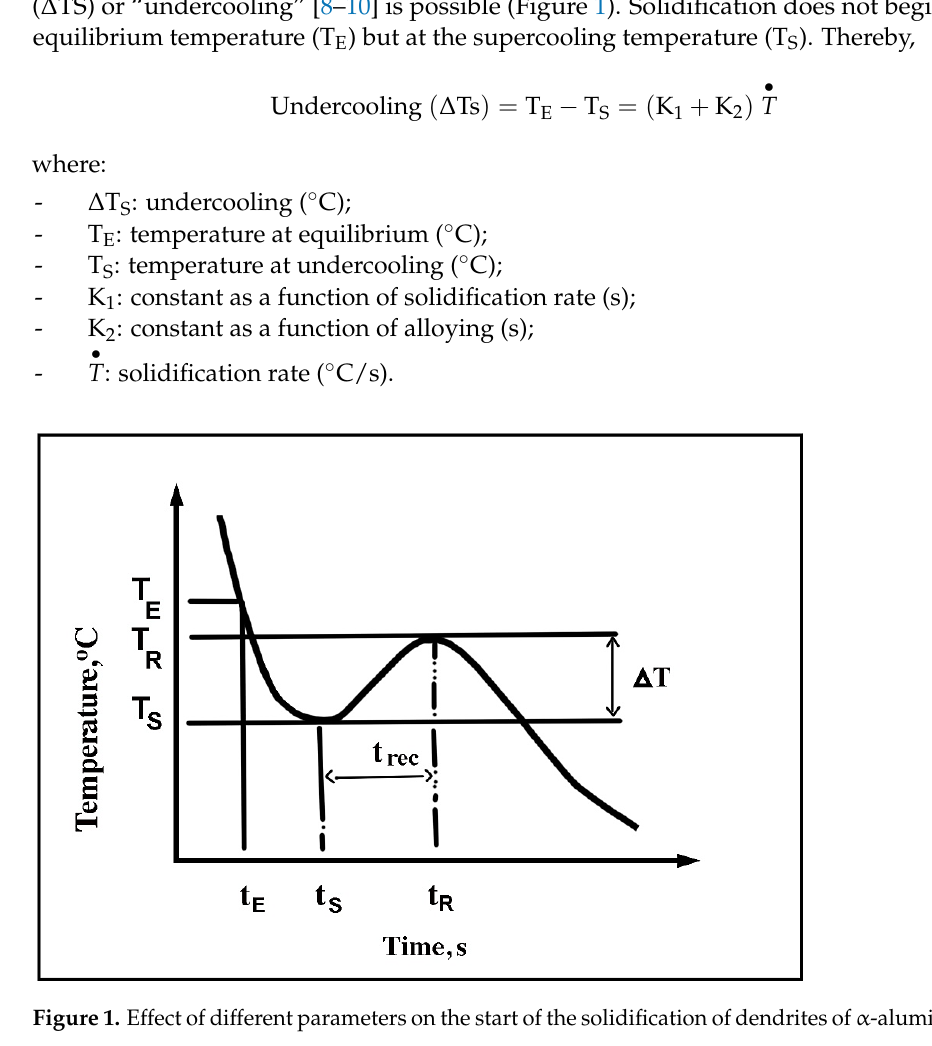
Figure 1. Effect of different parameters on the start of the solidification of dendrites of α -aluminum